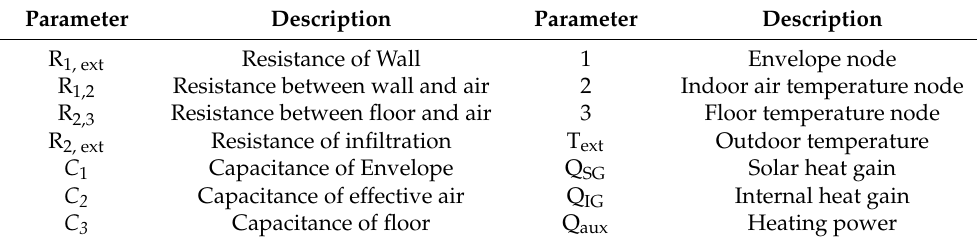
Table 1. Description of RC thermal network model parameters (4R3C).